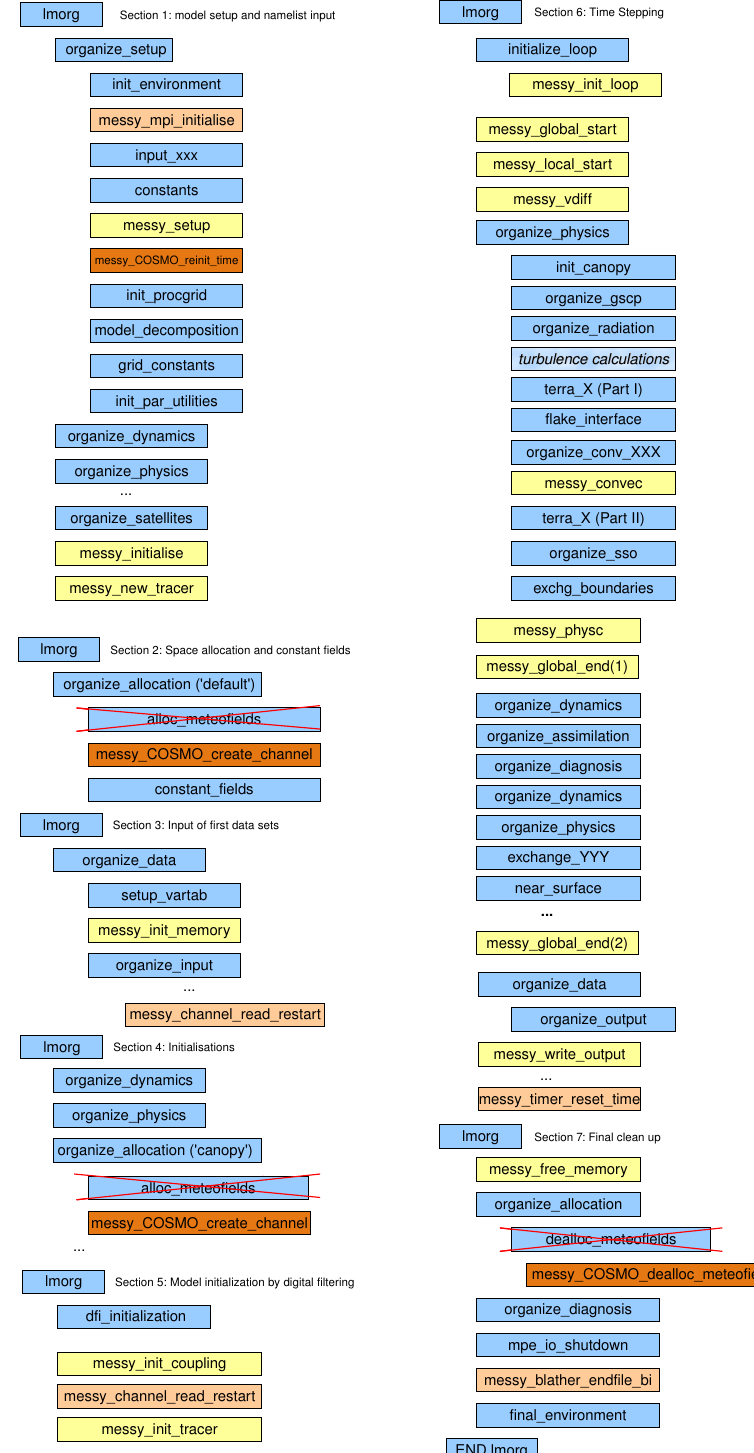
Fig. 3. Simplified flow chart of COSMO/MESSy. Listed are the main routine calls of COSMO and the MESSy entry points. Indented boxes are called by the non-indented box above. Blue boxes indicate COSMO routines; yellow boxes highlight MESSy entry points (CONTROL); orange boxes point to direct calls of MESSy infrastructure submodels and dark orange boxes indicate direct calls of COSMO specific MESSy infrastructure submodel routines.